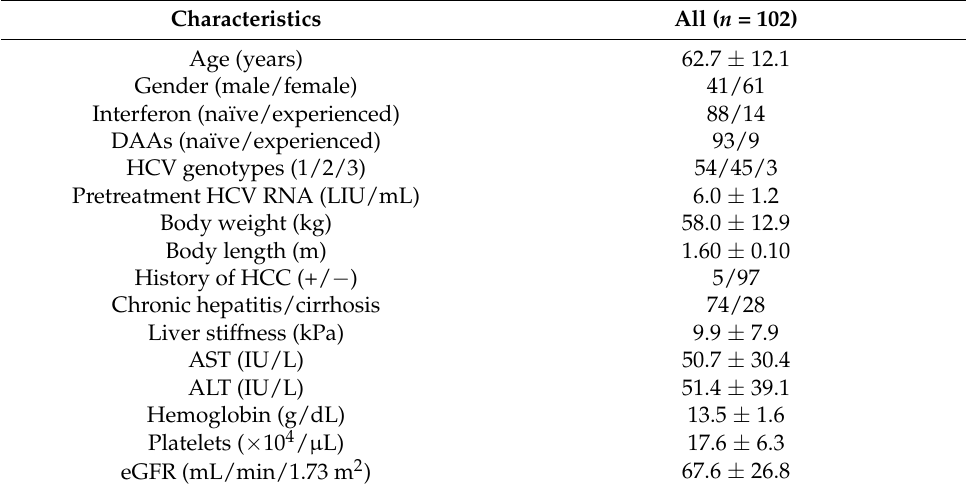
Table 1. Baseline characteristics of 102 patients in the